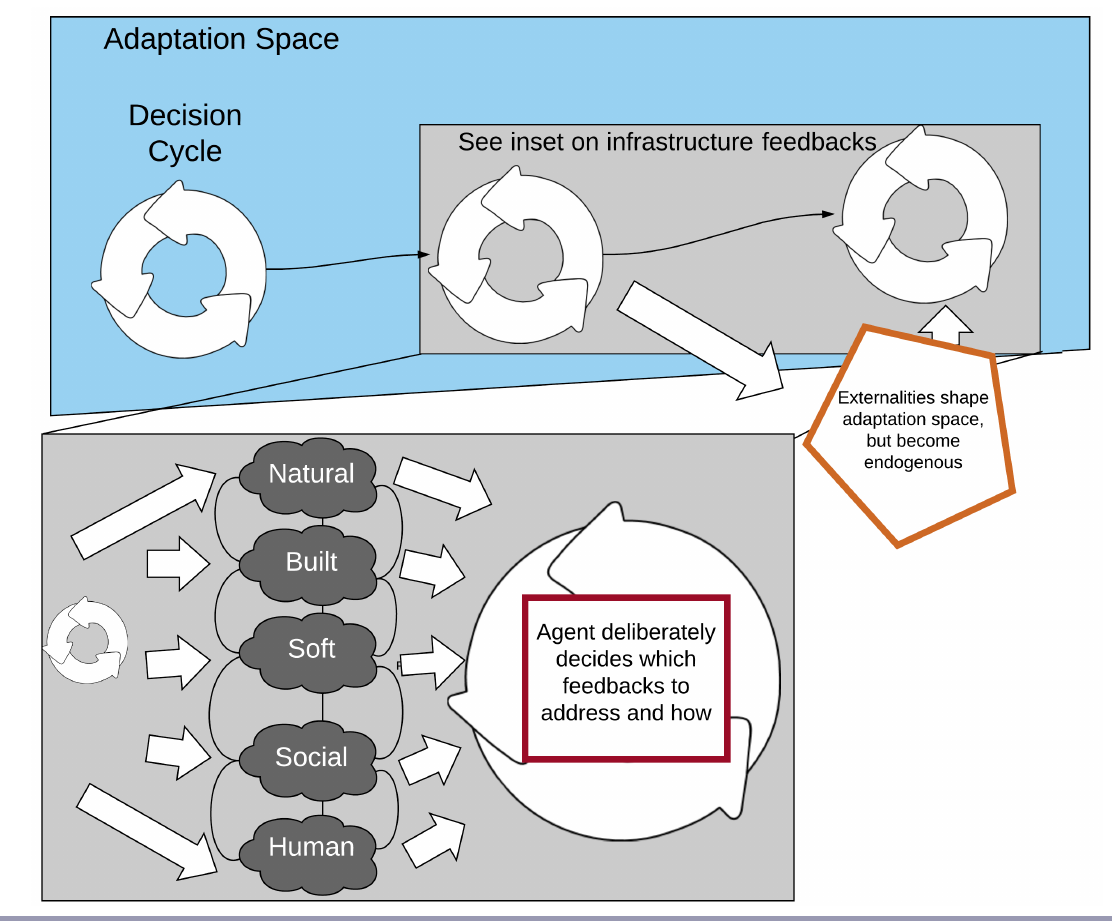
Fig. 1 . Coupled infrastructure pathways. A series of decision cycles create an adaptation pathway. In each cycle, an agent (or agents) makes deliberate adaptation decisions that selectively respond to changes in the coupled infrastructure system driven by the previous decision cycle. In an urban system, some adaptations have spatial or system externalities, which in turn influence the degree of choice available at any moment of time (the adaptation space). These externalities may even become endogenous as the city grows in space and complexity. Figure inspired by Wise et al. (2014) and Anderies (2015 b